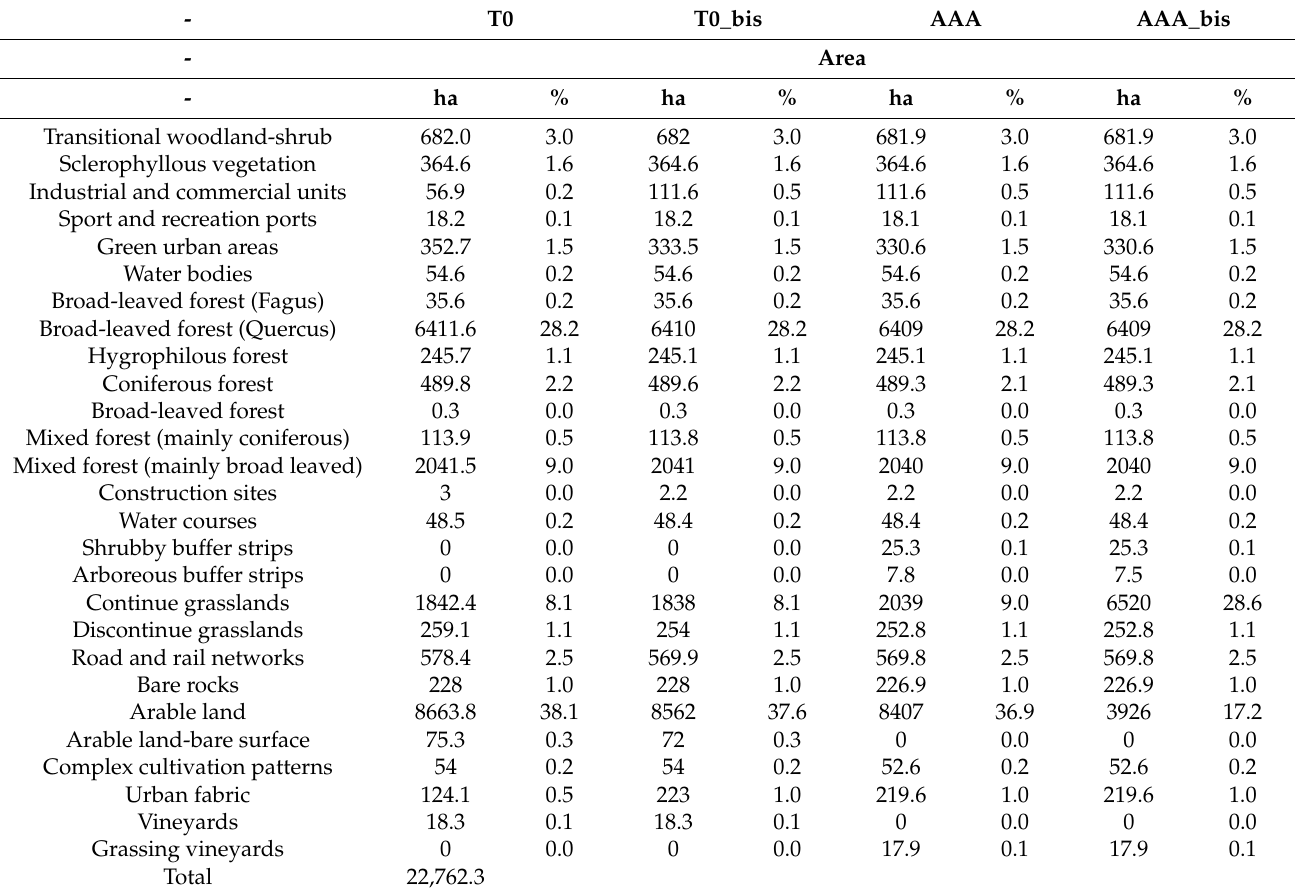
Table 4. Land use classes extension and % for each scenario.